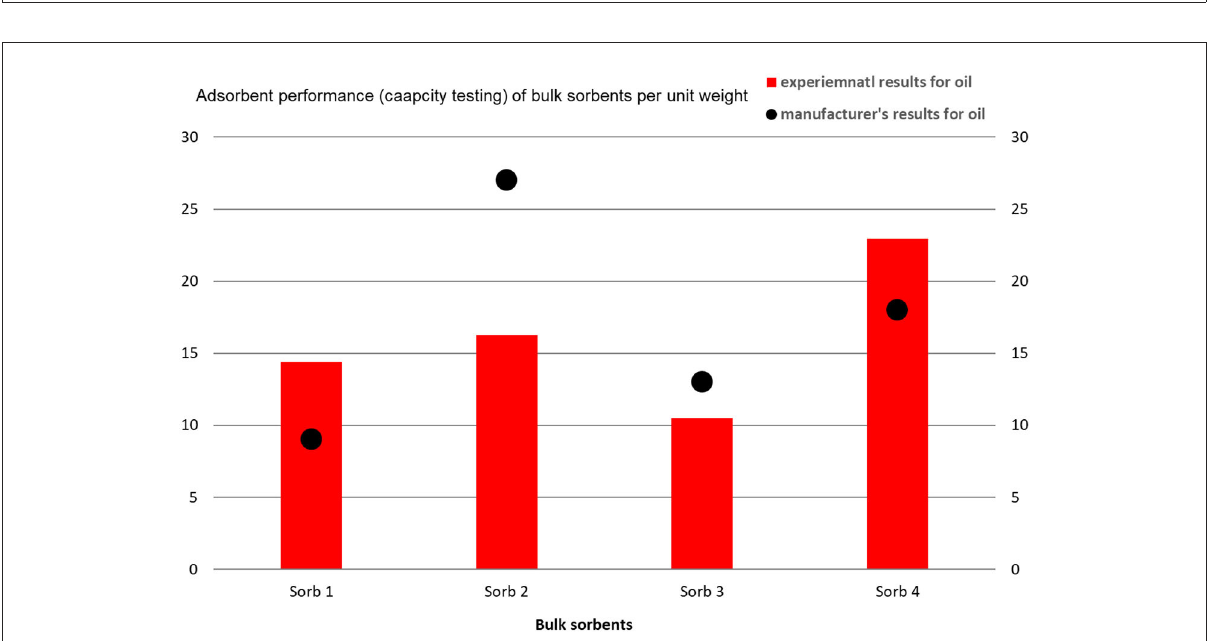
FIGURE5 Mutual comparison of the AC of chosen loose sorbents for the sorption of oils, which are experimentally stated and obtained from the values in the manufacturer’s technical documentation.